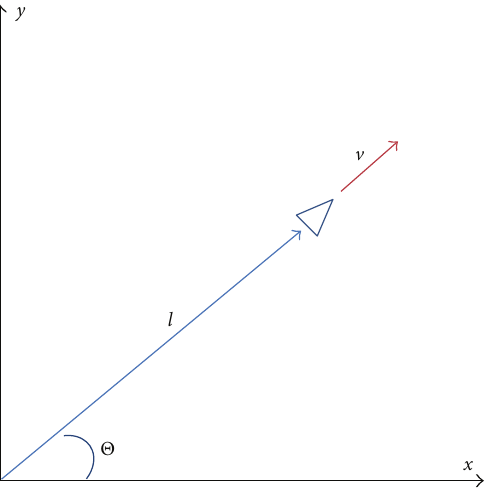
Figure 1: UAV in inertial reference